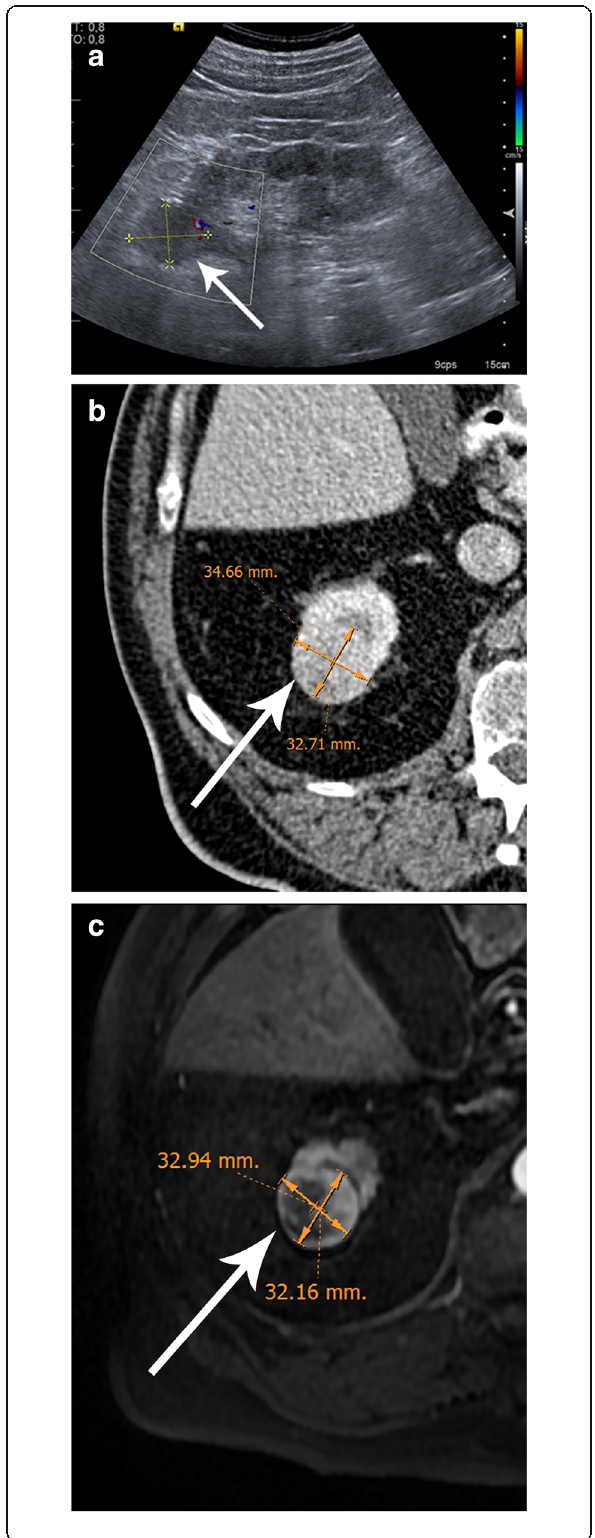
Fig. 8 Comparison of maximum tumor diameter (MTD) in the axial plane of a small renal mass (SRM) with different imaging modalities (arrows). a Sagittal ultrasound (US) view. b Axial contrast-enhanced CT scan and ( c ) axial contrast-enhanced T1-weighted MR of the same renal lesion demonstrating there are no significant differences between US, CT, and MR with the use of the same plane for measuring MTD (3.33 cm, 3.46 cm, and 3.29 cm, respectively). Note that the differences between different radiological tests are less than 0.2